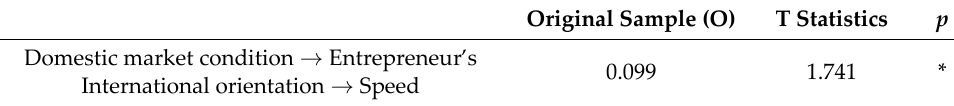
Table 4. Mediation (Indirect)